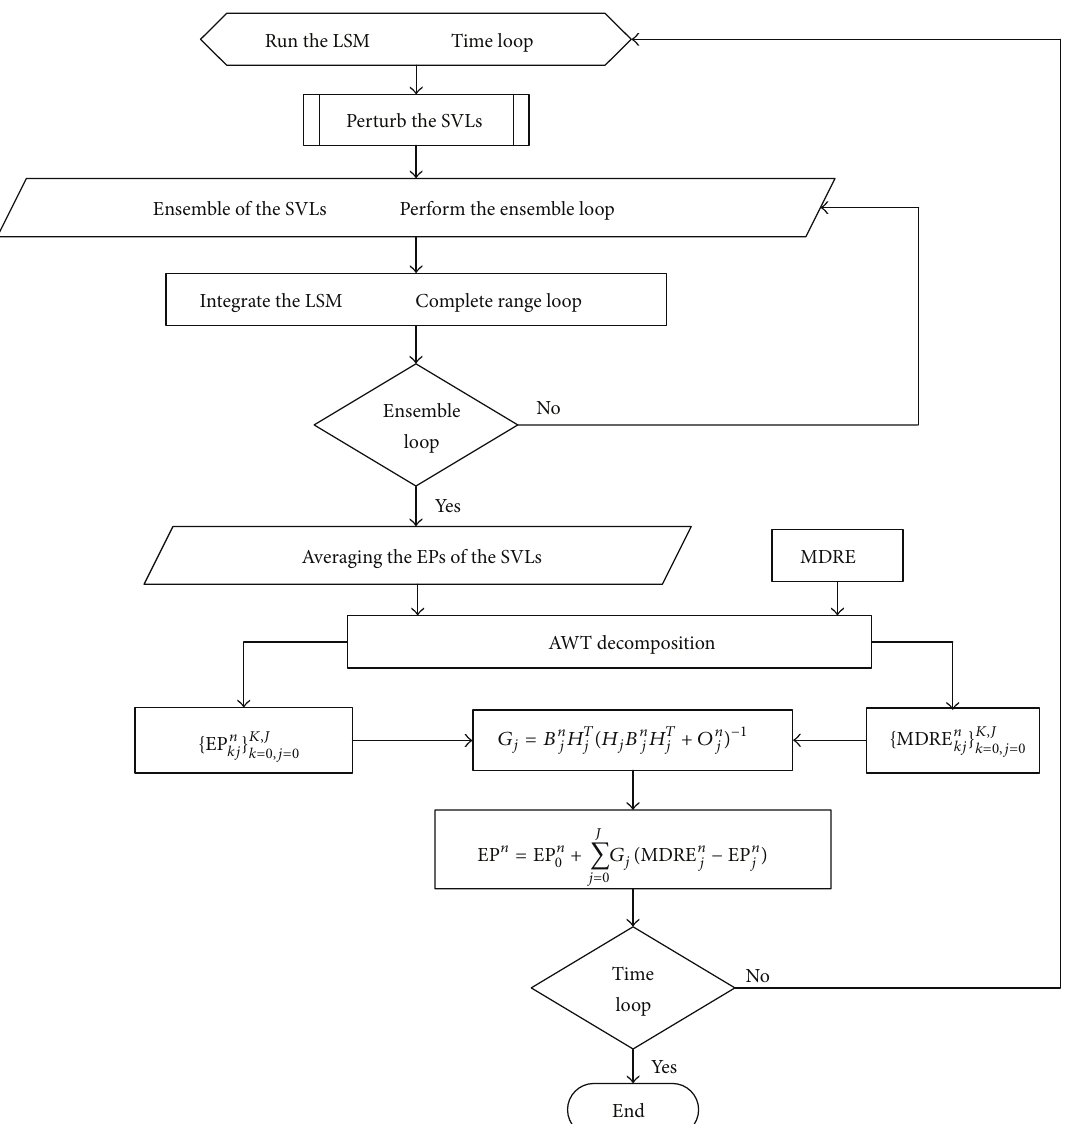
Figure 1: The schematic flowchart of the AWT-PEKF